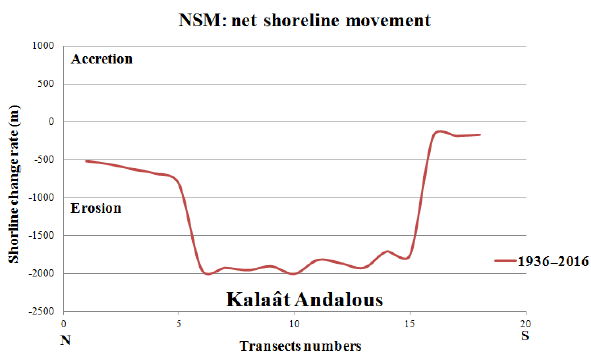
Figure 6. The rates of shoreline changes (MSN) in Kalaât An-